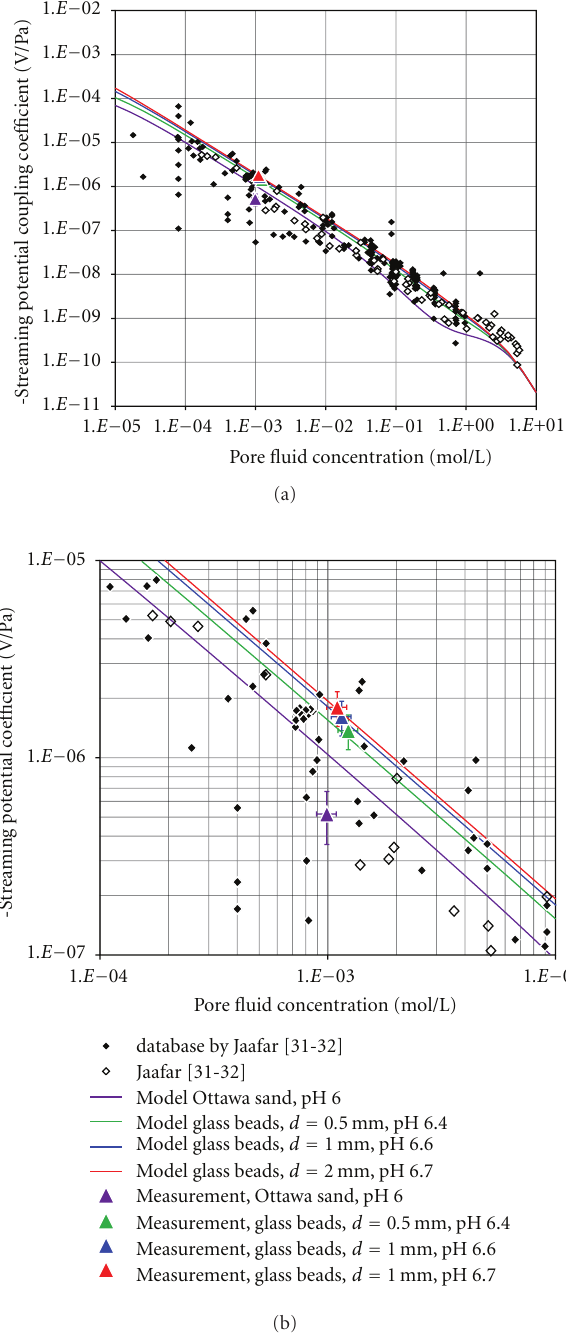
Figure 7: (a) The steady-state streaming potential coupling coef- ficient measured in this work shown with a compilation of silica- based earth materials measured by (open symbols) or compiled by (solid symbols) Jaafar [31, 32]. The lines represent the theoretically modelled streaming potential coupling coe ffi cient using the method of Glover et al. [16] and Glover and D´ery [17] and with the parameters Γ o = 5 sites/nm 2 , pK me = 7 . 5, pK − = 8, and T = 24 . 0 ◦ C, with the porosity, cementation exponent, grain size, and pH for the individual samples (given in Table 1). (b) The same diagram as (a) on an expanded